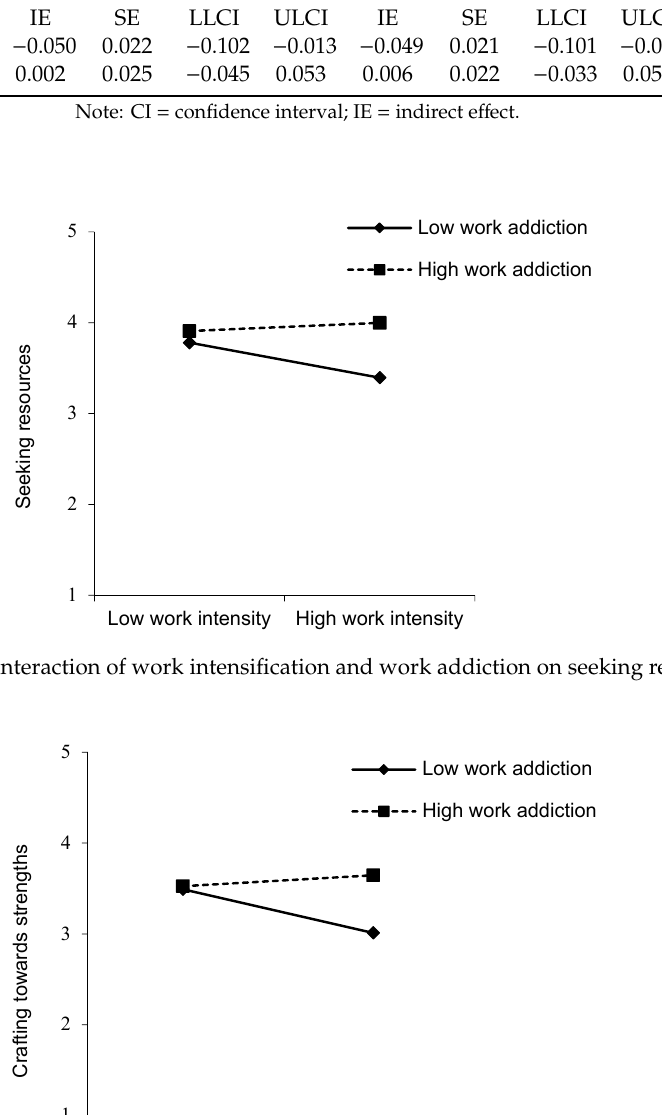
Table 4. Conditional indirect effect as a function of work addiction.